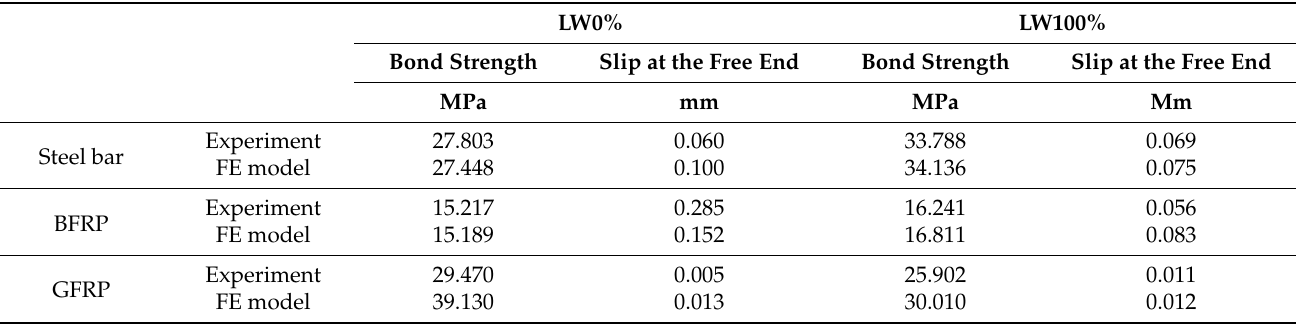
Figure 11. Crack width and pattern of the concrete cube after the P ‐ O failure of Ba ‐ LW0%. Table 6. Comparison of the maximum bond stress and the relative slip curves between the laboratory experiment and the numerical modeling.